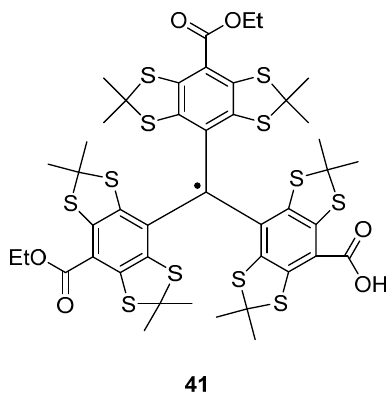
Figure 7. A tetrathiatriarylmethyl radical 41 .